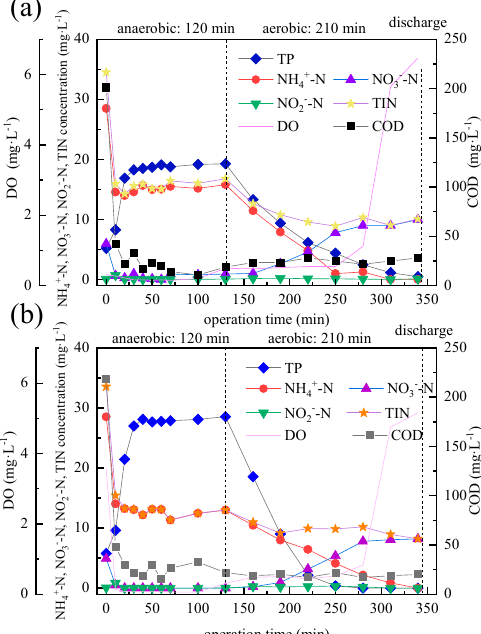
Figure 4. Variations of N, P and organic carbon in cyclic study in stage II (COD = 200 mg/L) (( a ): 100 kPa, ( b ): 72 kPa).